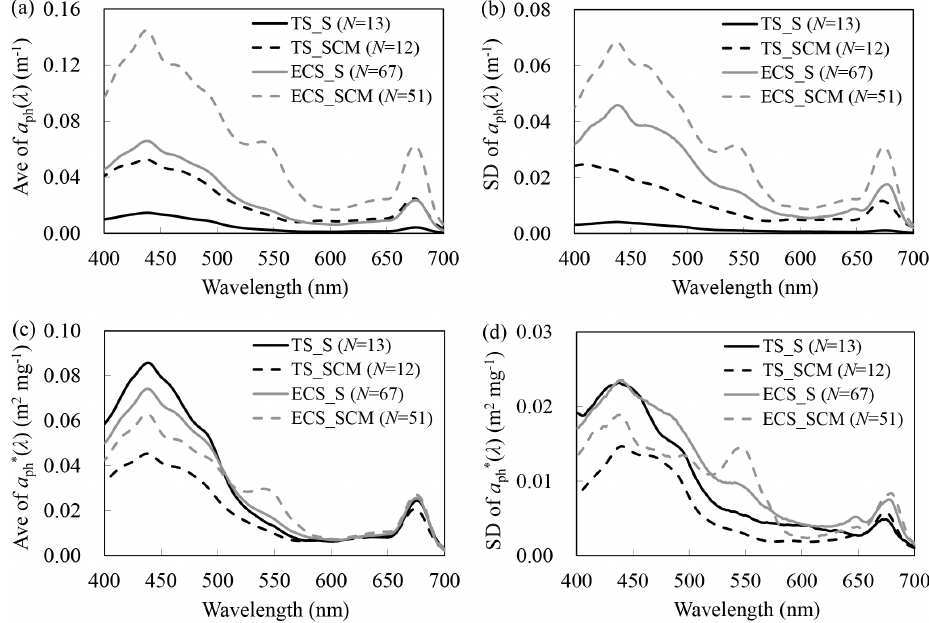
(λ) in the Tsushima Strait surface ph